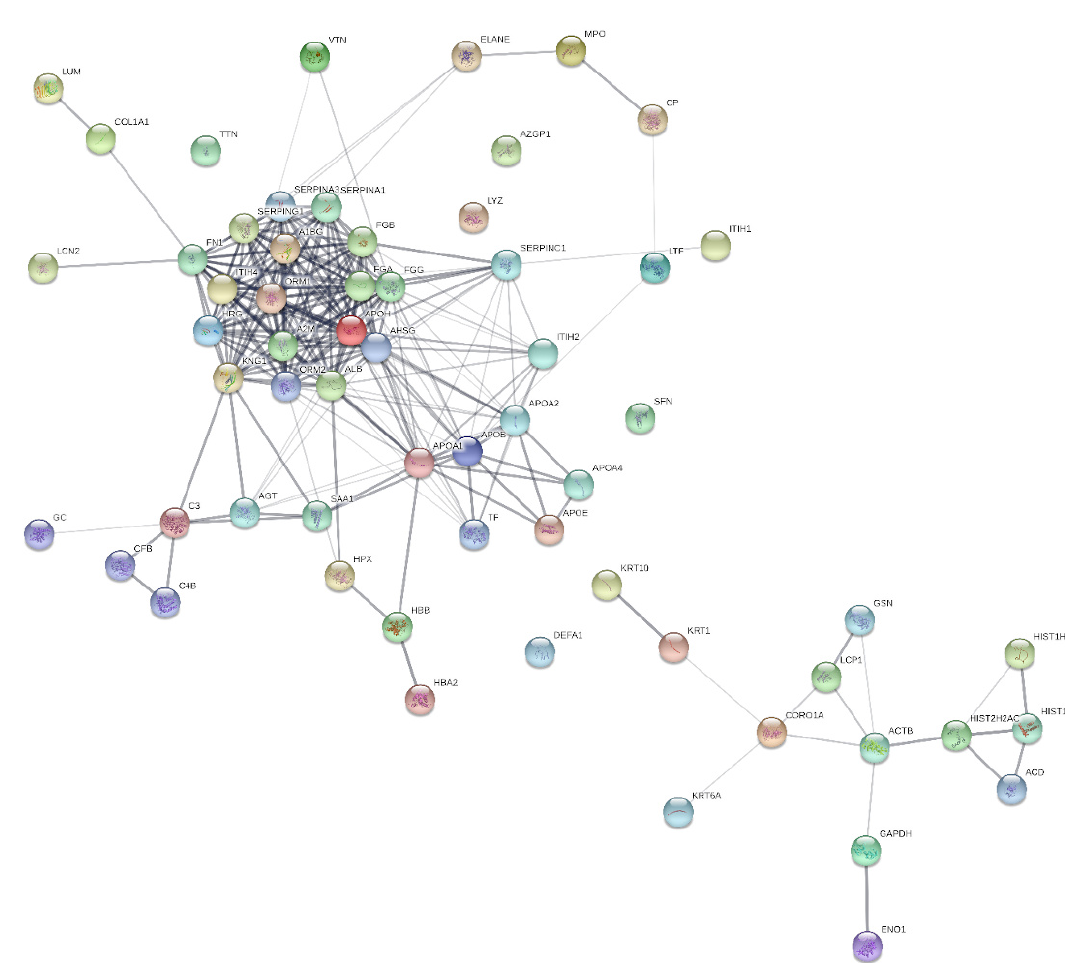
Figure 6. Protein-protein interactions network among all the proteins identified in the study by Cavassan et al. [68] using String software. The darker lines represent high interaction whereas lighter ones represent weaker interactions. (From: Cavassan NRV, et al. Correlation between chronic venous ulcer exudate proteins and clinical profile: A cross-sectional study. J Proteomics.